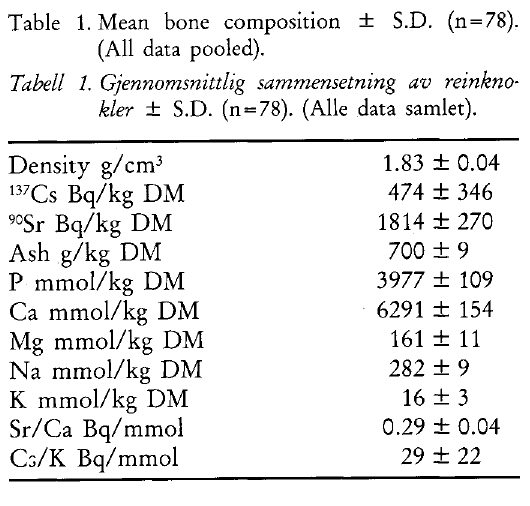
Table 1. Mean bone composition ± S.D. (n = 78). (All data pooled).